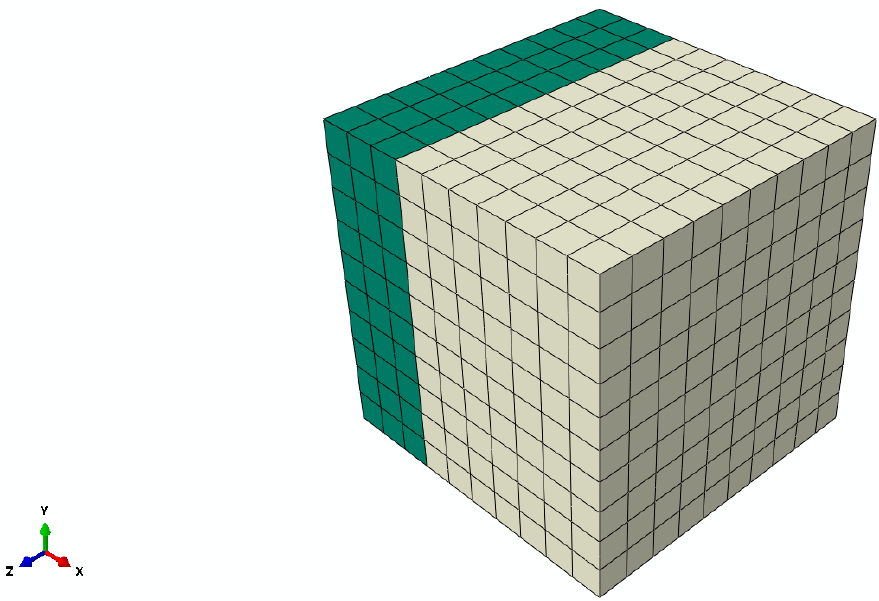
Figure 3. Polycrystal sample consisting of two grains (loaded is in the z -direction).